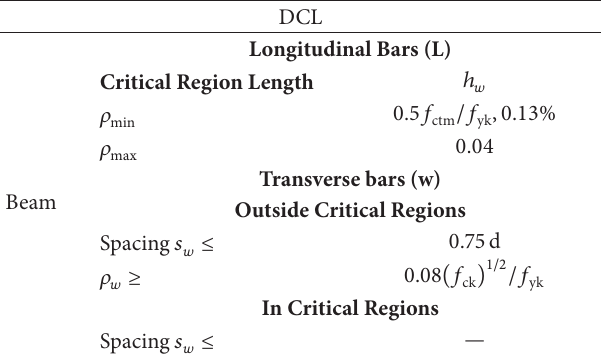
Table 3: Connection design formulas for ductility classes low in